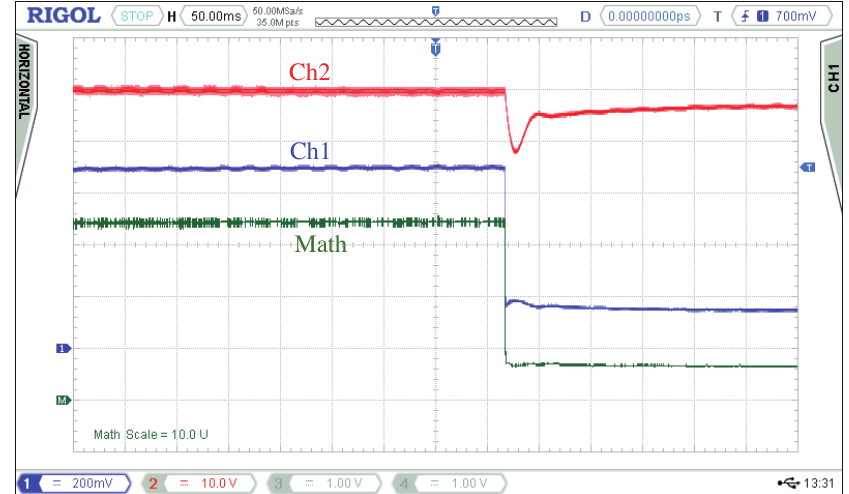
Figure 16. Transient response against an irradiance step from PV1 to PV4. Ch1: PV current (2 A/div). Ch2: PV voltage (10 V/div). Math: PV power (100